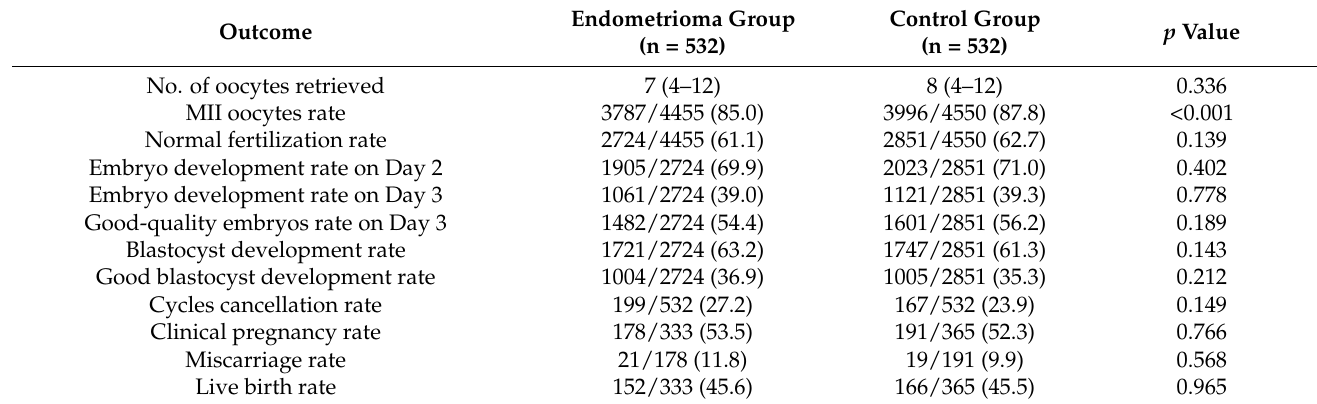
Table 2. Outcomes of the women with endometrioma and control group after PSM.